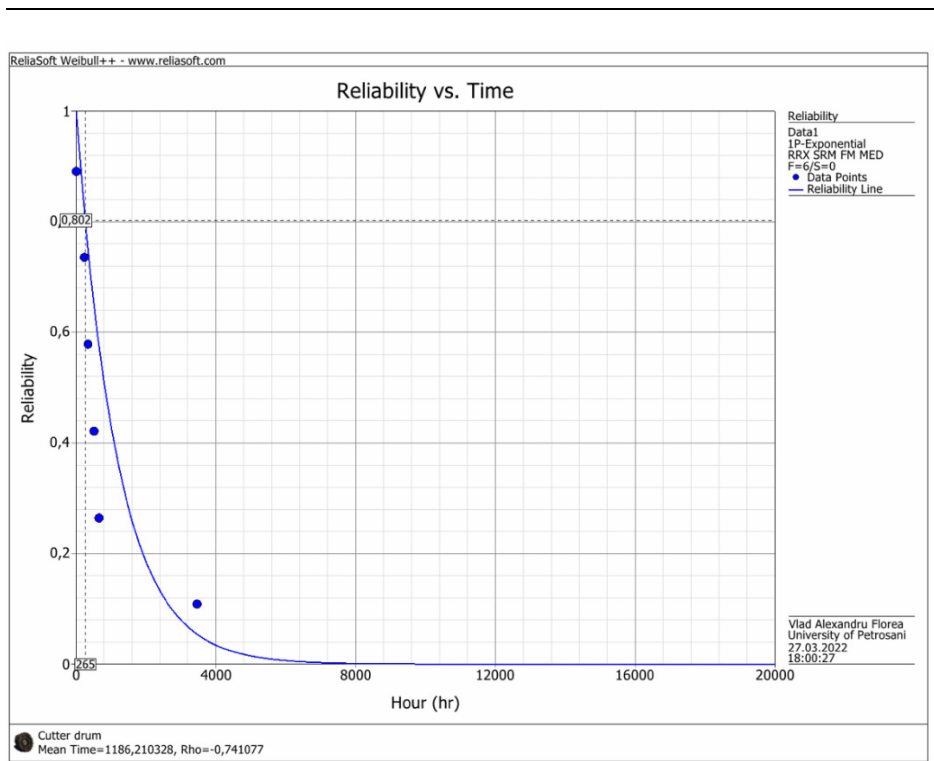
Figure 12. Cleat reliability values for an 80.2% confidence level for the cutter